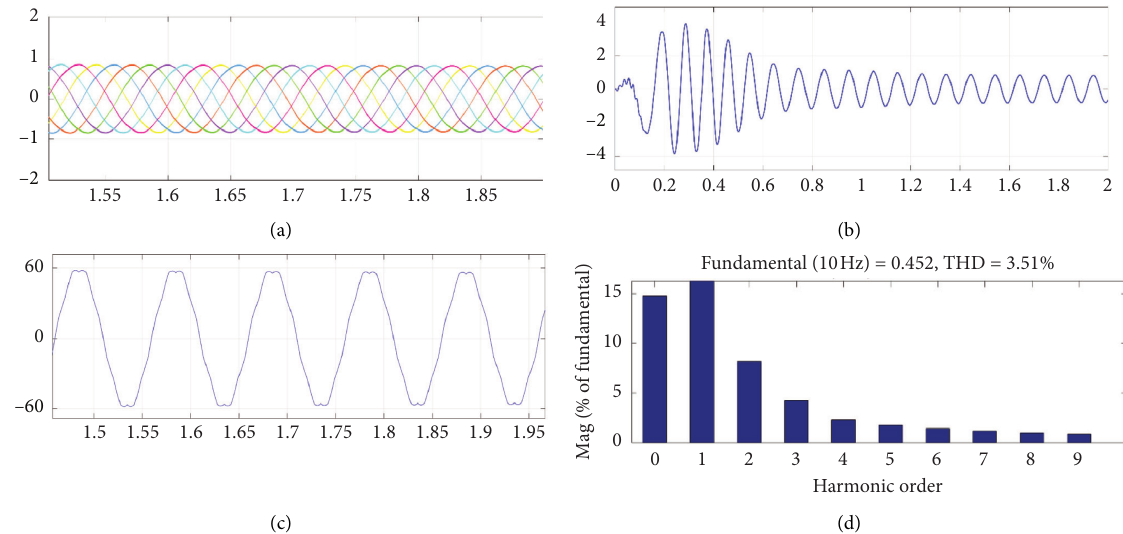
Figure 9: Simulation results of NSV-SVPWM, (a) seven-phase current waveform, (b) phase current waveform, (c) phase voltage waveform, (d) FFT analysis.